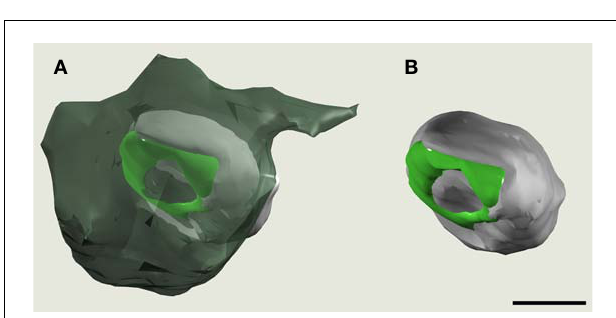
FIGURE 5 | A perforated synapse serially sectioned. (A-P) In this series of sections only every second section has been represented. The synaptic contact (arrows) is established between an axon terminal that contains numerous synaptic vesicles and a dendritic spine [ax and d, respectively, in (A) ]. Although the section plane appears to be oblique with respect to the synaptic junction, the synaptic cleft is partially visible in sections (E) and (F) . This synapse can be identifi ed as asymmetric on the basis of the prominent post-synaptic density